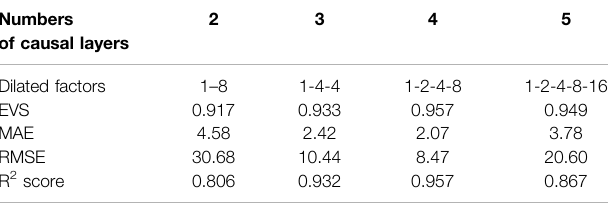
TABLE 2 | Metrics with or without CAE. Network structure